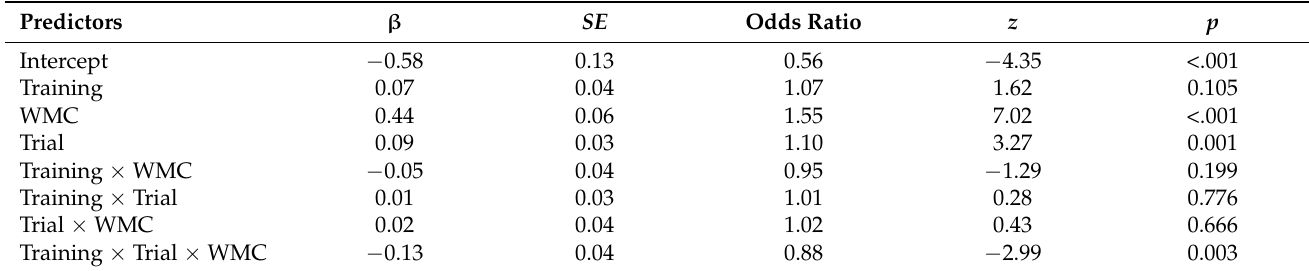
Table 4. Predicting figural analogy accuracy with WMC, training, and